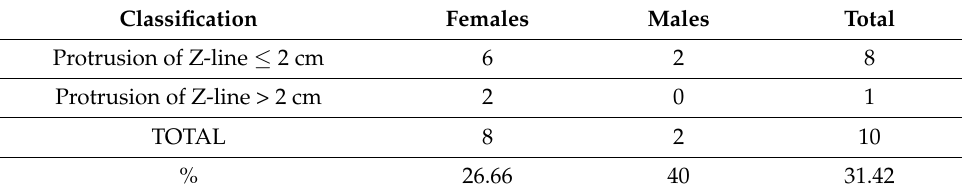
Table 8. Irregularities of the Z-line in post-operative endoscopic